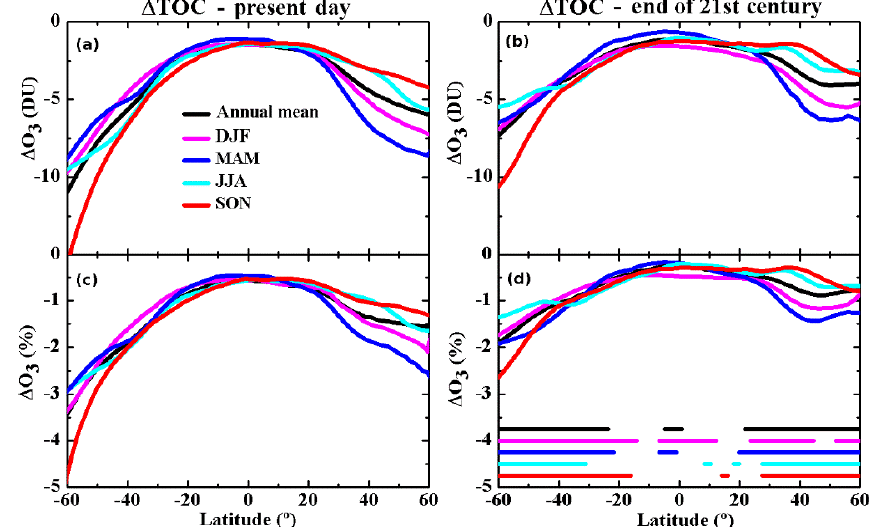
Figure 5. Latitude distributions of total ozone column difference ( (cid:49) TOC) between the experiments. Panels (a) and (b) show the annual and seasonal mean absolute (cid:49) TOC (DU) for the present day and the end of 21st century, respectively, while panels (c) and (d) show the corresponding relative (cid:49) TOC (%). The corresponding horizontal lines shown in panel (d) indicate where the relative (cid:49) TOC values between the present day and the end of the 21st century are statistically significant with a 95% confidence interval using a two-tailed Student’s t